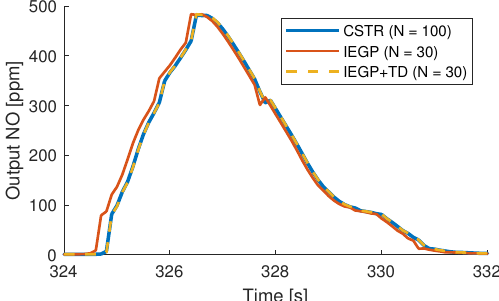
Figure 8. Output NO for a part of the WHTC cycle for three different